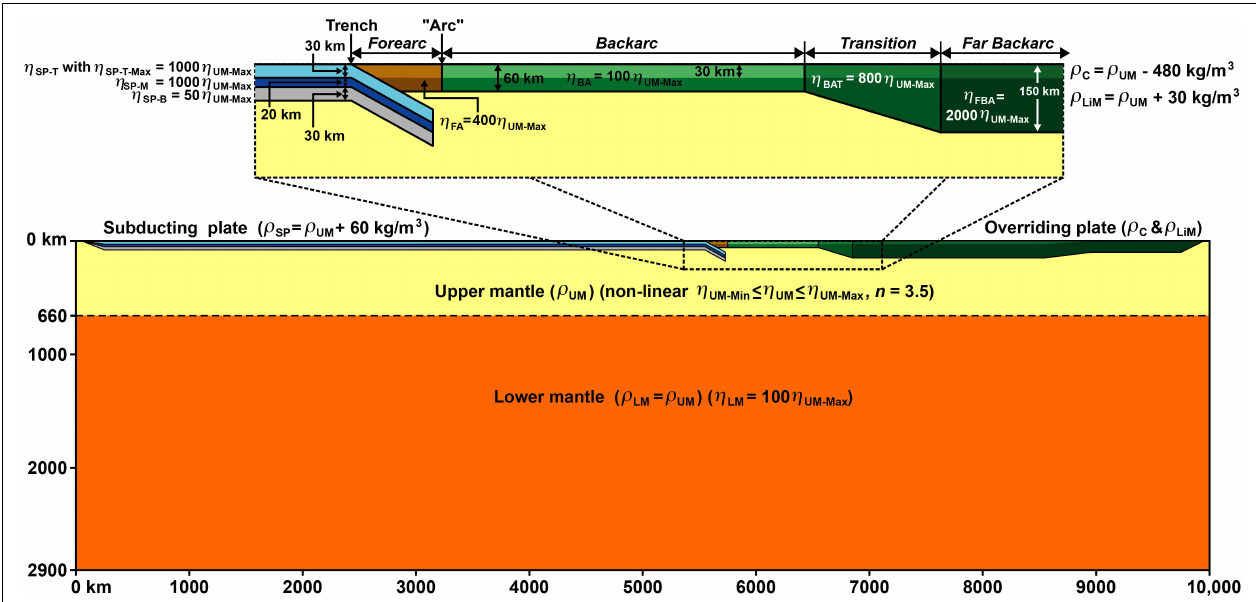
FIGURE 3 | Cross-section through the center of the numerical domain showing the model set-up to investigate buoyancy-driven time-evolving subduction in a very large domain with a layered whole mantle reservoir. The four models reported in the paper are all the same in cross-section but differ in trench-parallel extent with a different box width ( BW ) and slab width ( W ): the narrow slab model with BW = 4000 km and W = 600 km; the intermediate-width slab model with BW = 6000 km and W = 2000 km; the wide slab model with BW = 12,000 km and W = 6000 km; and the very wide slab model with BW = infinite and W = infinite (2D model set-up). The geodynamic models include a layered negatively buoyant subducting plate with three layers with different viscosity (top, middle and bottom) and a layered overriding plate with two layers with the same viscosity but different density (crustal layer and lithospheric mantle layer). η SP − T = subducting plate top layer viscosity, η SP − T − Max = subducting plate top layer maximum viscosity, η SP − M = subducting plate middle layer viscosity, η SP − B = subducting plate bottom layer viscosity, η FA = forearc viscosity, η BA = backarc viscosity, η BAT = backarc transition zone viscosity, η FBA = far backarc viscosity, η UM = sub-lithospheric upper mantle viscosity, η UM − Min = minimum sub-lithospheric upper mantle viscosity, η UM − Max = maximum sub-lithospheric upper mantle viscosity, η LM = lower mantle viscosity, ρ UM = sub-lithospheric upper mantle density, ρ LM = lower mantle density, ρ ρ ρ LiM = continental SP = subducting plate density, C = continental crustal density, and lithospheric mantle density. All the box boundaries have a free-slip